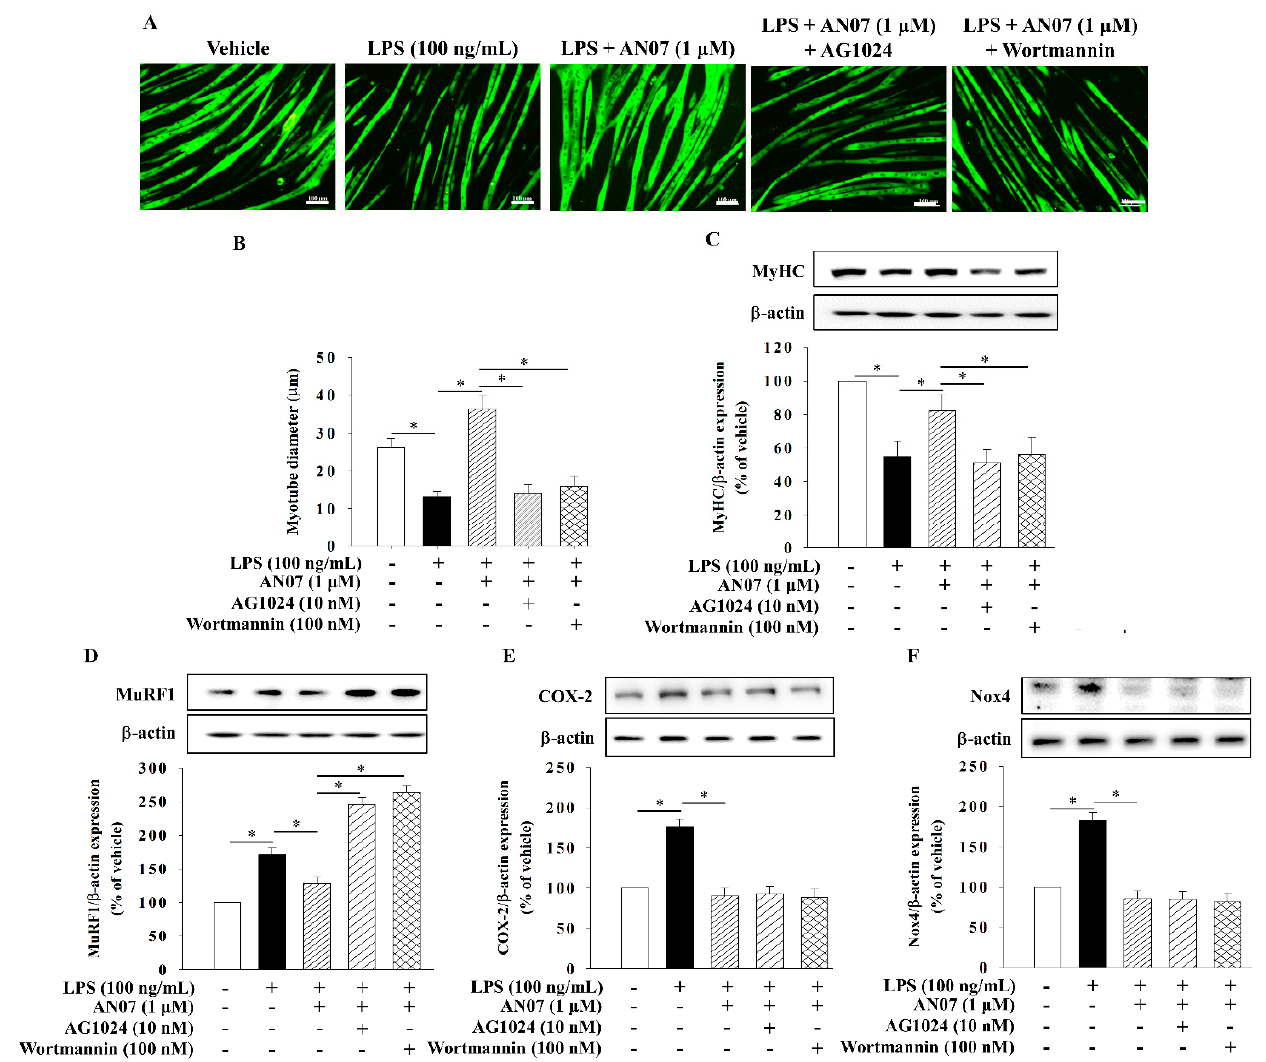
Figure 9. AG1024 (IGF-1R inhibitor) and wortmannin (PI3K inhibitor) attenuated the AN07-mediated antiatrophic effects and MuRF1 downregulation in LPS-induced C2C12 myotubes. Myotubes were treated with or without AG1024 (10 nM) or wortmannin (100 nM) for 1 h before AN07 (1 μ M) treatment for 1 h and then treated with LPS (100 ng/mL) for ( E ) 2 h or ( A – D , F ) 24 h. ( A ) The morphology of myotube were visualized by immunofluorescence staining of MyHC (green). ( B ) Myotube diameter were quantified. Scale bar = 100 μ m. The protein expressions of ( C ) MyHC, ( D ) MuRF1, ( E ) COX-2, and ( F ) Nox4 were measured by Western blotting. Densitometry analyses are presented as the relative ratio of protein/ β -actin and are represented as percentages of the control group. Data represent the mean ± SEM from six independent experiments (n = 6). * p < 0.05 indicated significant difference between groups according to one-way ANOVA followed by a Tukey post-hoc test ( B ) or Kruskal–Wallis test followed by Dunn’s test ( C – F ).